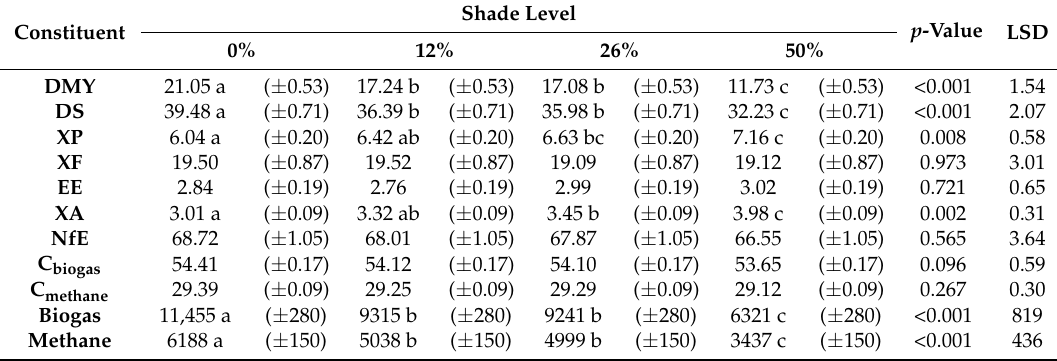
Table 4. Means for DMY (Dry Matter Yield, Mg ha − 1 year − 1 ), DS (Dry Substance, %), biogas, and methane quality parameters (XP, XF, EE, XA and NfE) (% of dry matter), conversion factor C biogas and C methane and theoretical biogas- and methane yield (m 3 ha − 1 ) for the different shade levels (0%, 12%, 26%, and 50%) over the three experimental years (2015–2017).